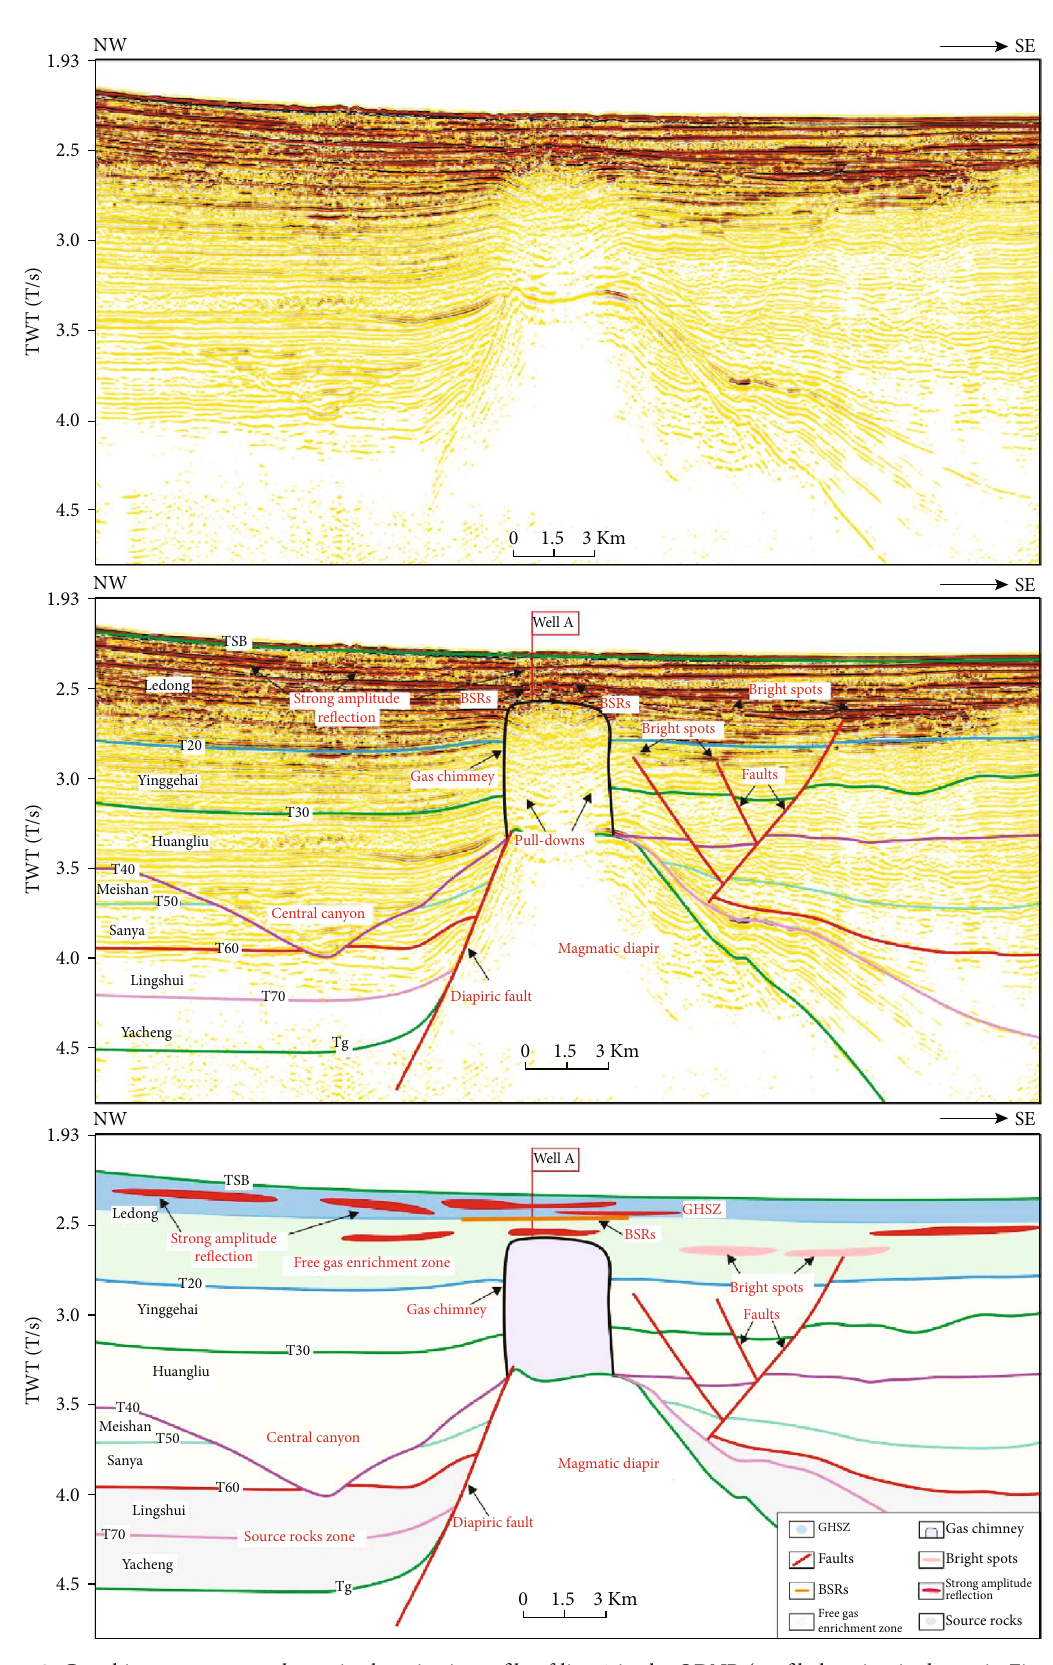
Figure 3: Gas chimney structure shown in the seismic pro fi le of line 1 in the QDNB (pro fi le location is shown in Figure